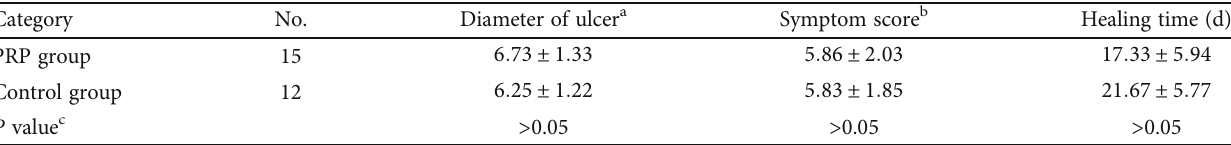
Table 2: Comparison of healing time between the PRP group and control group in peptic ulcer healing. Category